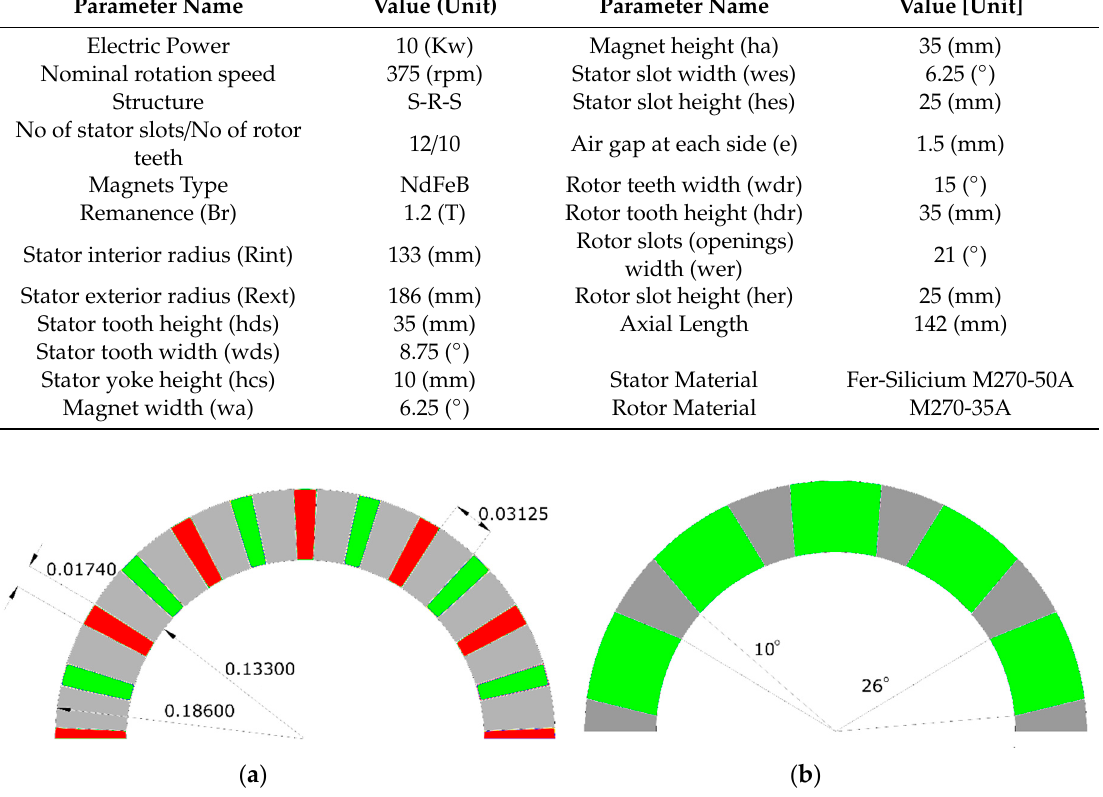
Table 1. The design variables describing the AFSPM prototype.